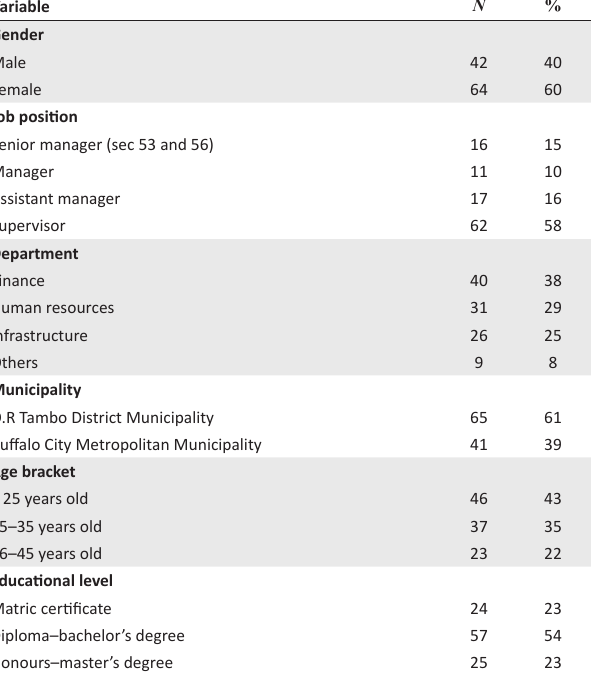
TABLE 1-A2: Demographic